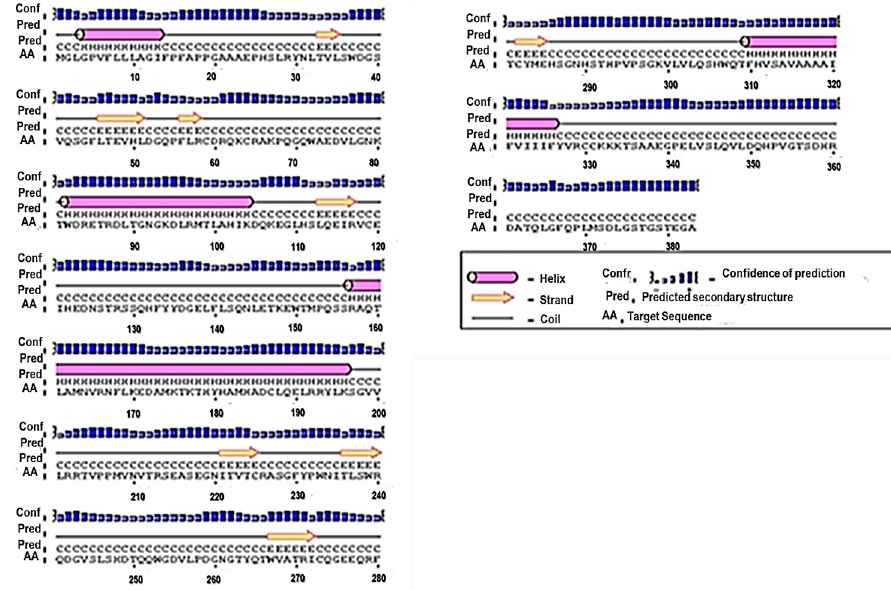
Figure 1. Predicted secondary structure of MIC-A. Using PSIPRED, the secondary elements in the protein were predicted to consist of four α -helices and eight β -sheets.